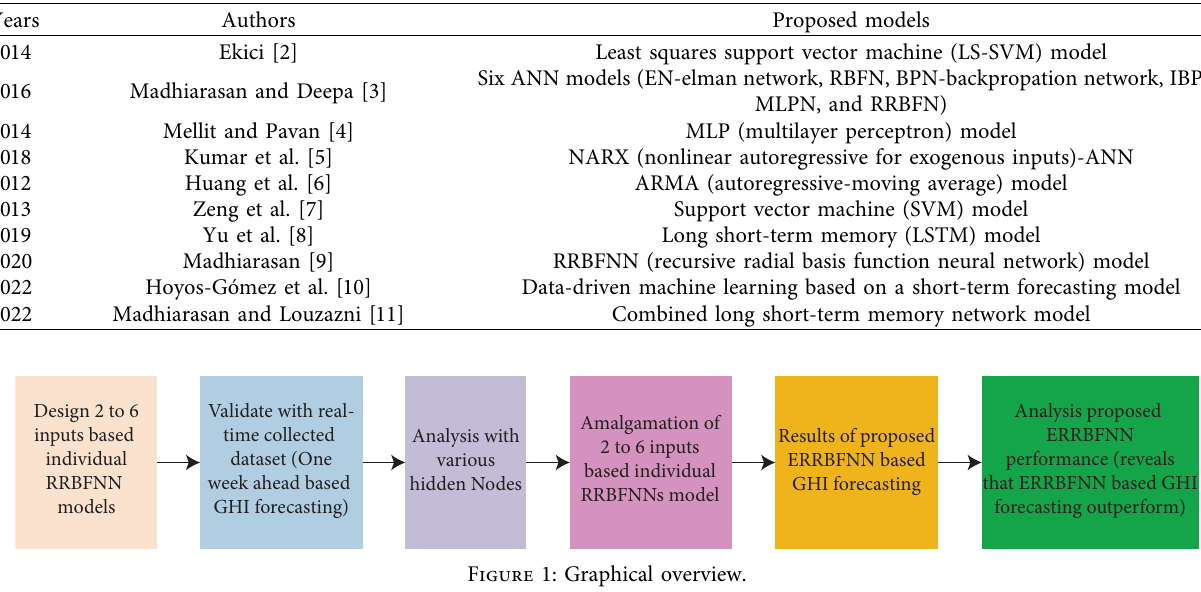
Table 1: Literature comparative